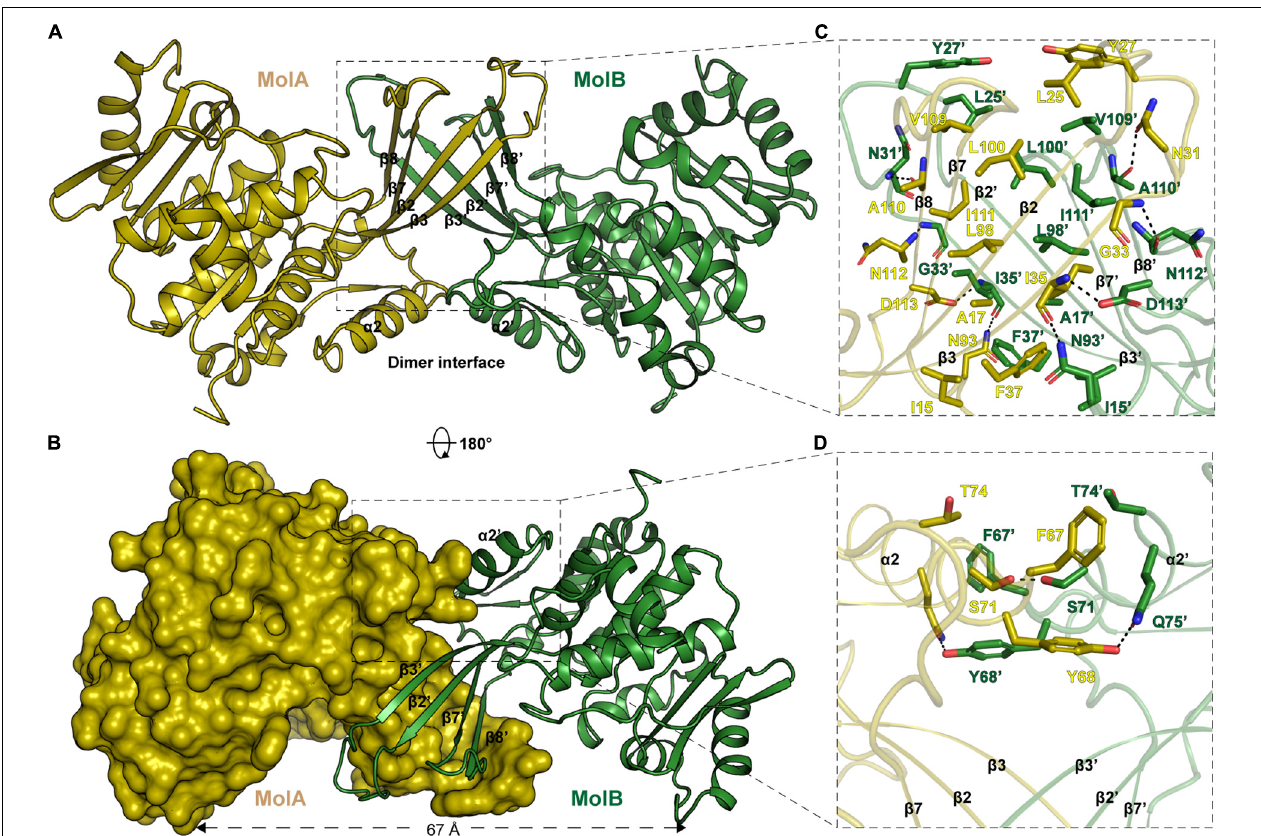
FIGURE 2 | Structure of Ec PsuK homodimer. (A) Dimeric structure of Ec PsuK is shown as the cartoon; the two protomers are colored yellow and green. The dimer interface is indicated by a black box. (B) Surface representation of the dimer interface. (C) Detailed interactions for dimerization within the β -thumb region. The hydrogen bonds are shown as black dashed lines. (D) Detailed interactions between α 2 and α 2 (cid:48) . The hydrogen bonds are shown as black dashed